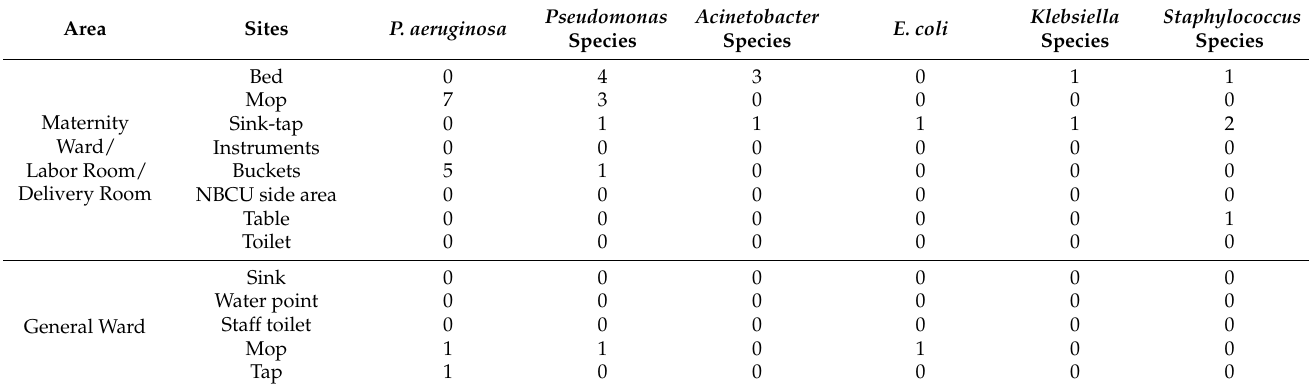
Table 1. Presence of microorganisms stratified with the sample sites from selected ten healthcare facilities of Gujarat, India.